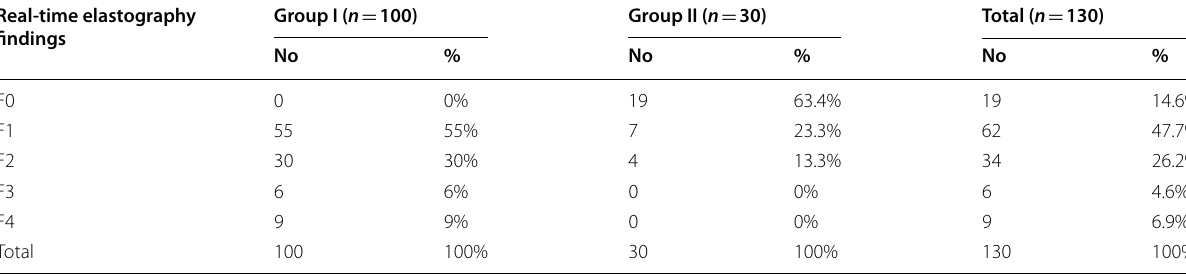
Table 5 Real-time elastography findings among the studied groups Real-time elastography